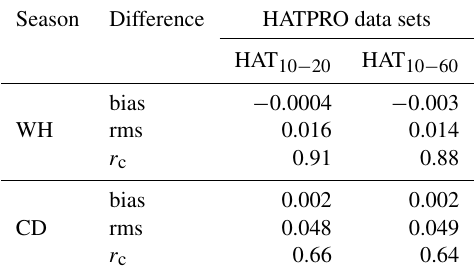
Table 3. The bias (SEVIRI minus HATPRO) and rms difference (kgm − 2 ) between the daily median LWP values derived from satel- lite and ground-based observations. Correlation coefficient r c is also